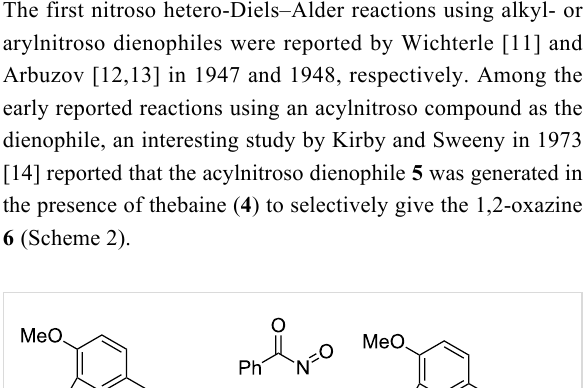
Arylnitroso compounds are, in comparison to acylnitroso ana- logues, quite stable, and in many cases, they can be isolated and stored. An extensive review by Gowenlock and